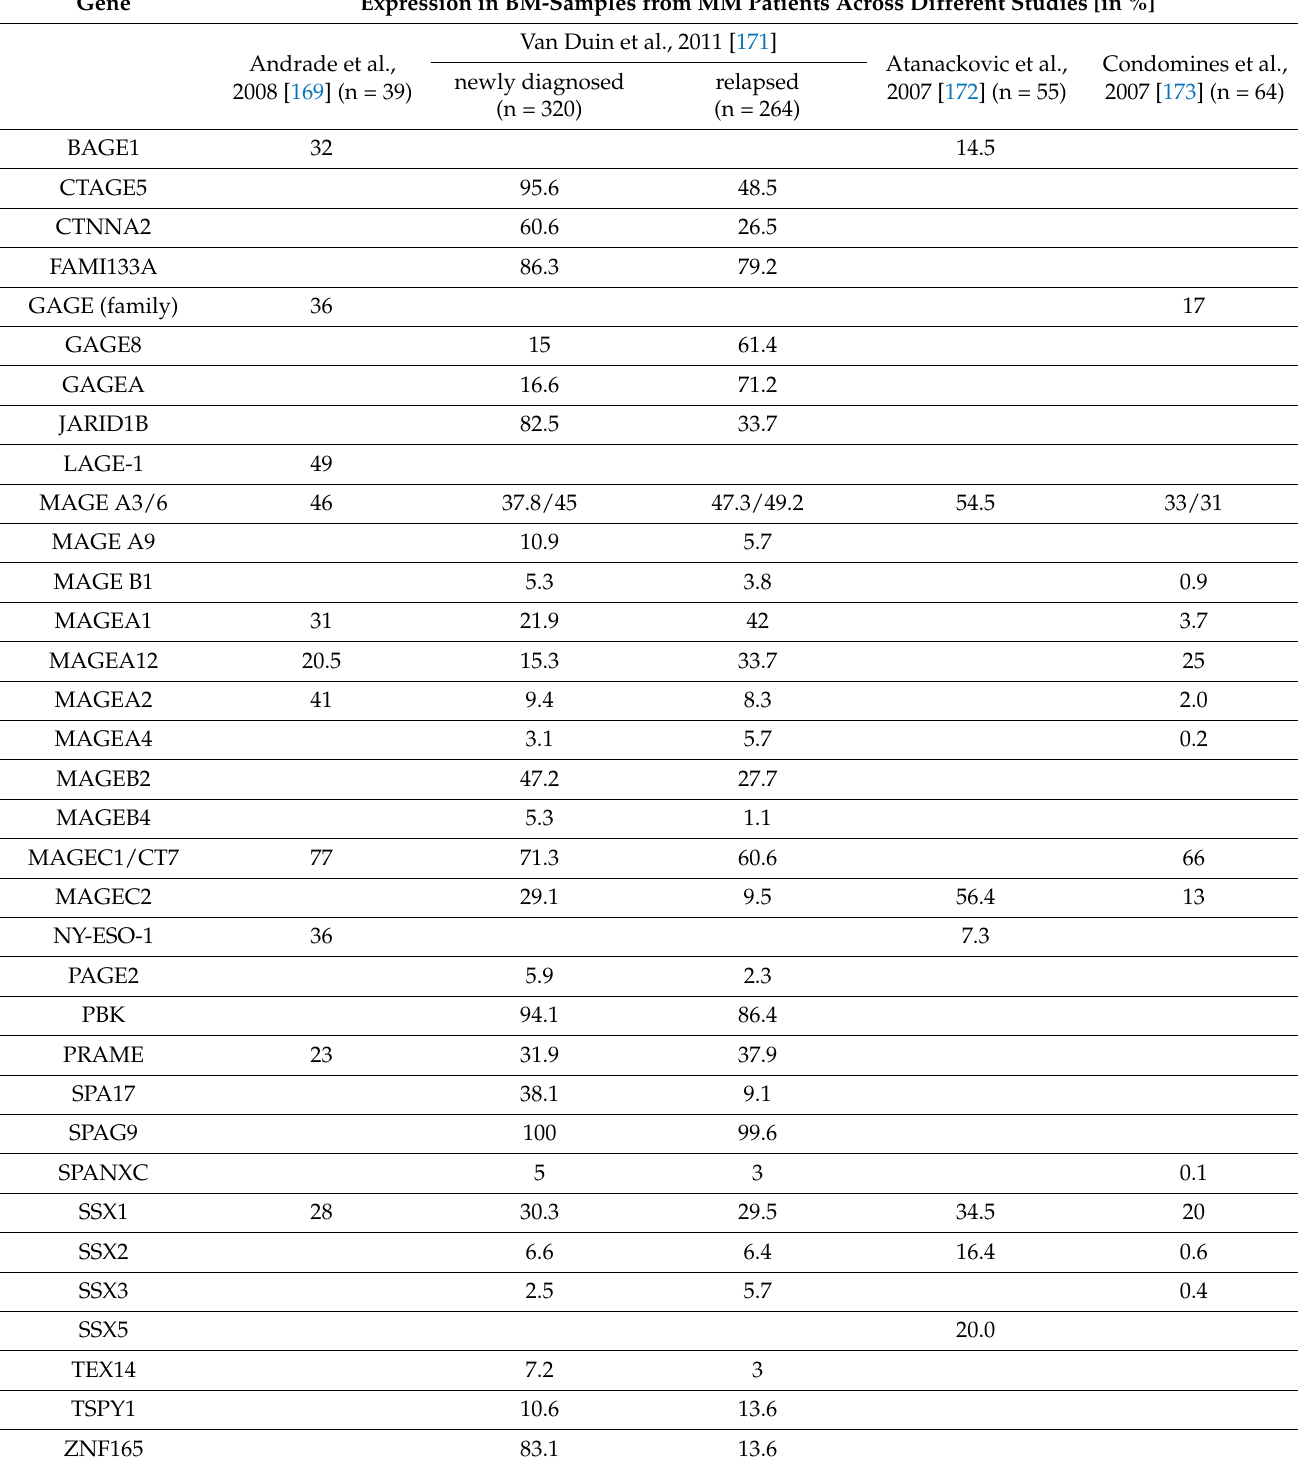
Table 3. Frequently expressed cancer-testis antigens in MM patient cohorts. Gene Expression in BM-Samples from MM Patients Across Different Studies [in